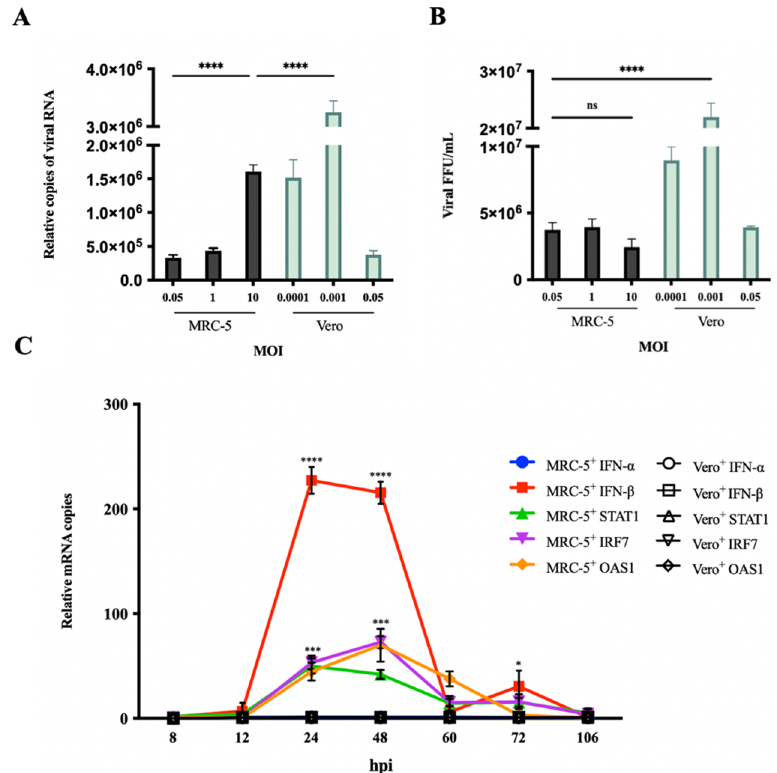
Figure 1. RABV infection activated IFN signaling pathway-related gene expression. ( A , B ) MRC-5 cells were infected with the PM RABV strain at MOI of 0.05, 1, and 10. Vero cells were infected with the aG RABV strain at an MOI of 0.0001, 0.001, and 0.05. RABV RNA expression and titer in culture supernatant were detected by qRT-PCR and FFU assays at 168 hpi. ( C ) MRC-5 cells were infected with the PM RABV strain at an MOI of 0.05. Vero cells were infected with the aG RABV strain at an MOI of 0.001. The total RNA from cells was extracted at 8, 12, 24, 48, 60, 72, and 106 hpi, and the mRNA expression of IFN- α , IFN- β , STAT1, IRF7, and OAS1 was detected by qRT-PCR. Data are shown as fold change in expression of mRNA for each IFN- α , IFN- β , STAT1, IRF7, and OAS1 compared with that of uninfected MRC-5 or Vero cells, respectively, at the indicated time point and normalized to the values for 18S rRNA. + : RABV infection; * p < 0.05; *** p < 0.001; **** p < 0.0001; ns p ≥ 0.05 compared with Vero + at the indicated time point.